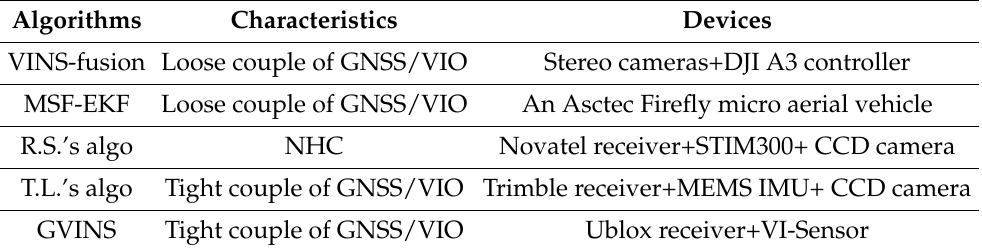
Table 2. Works on the fusion of